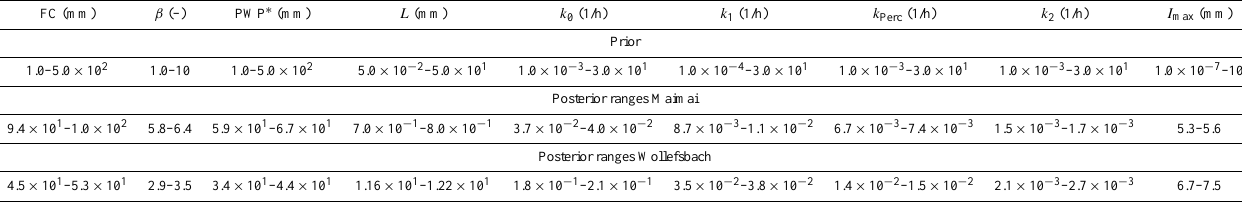
Table 4. Prior and posterior parameter ranges for both catchments for HBV.